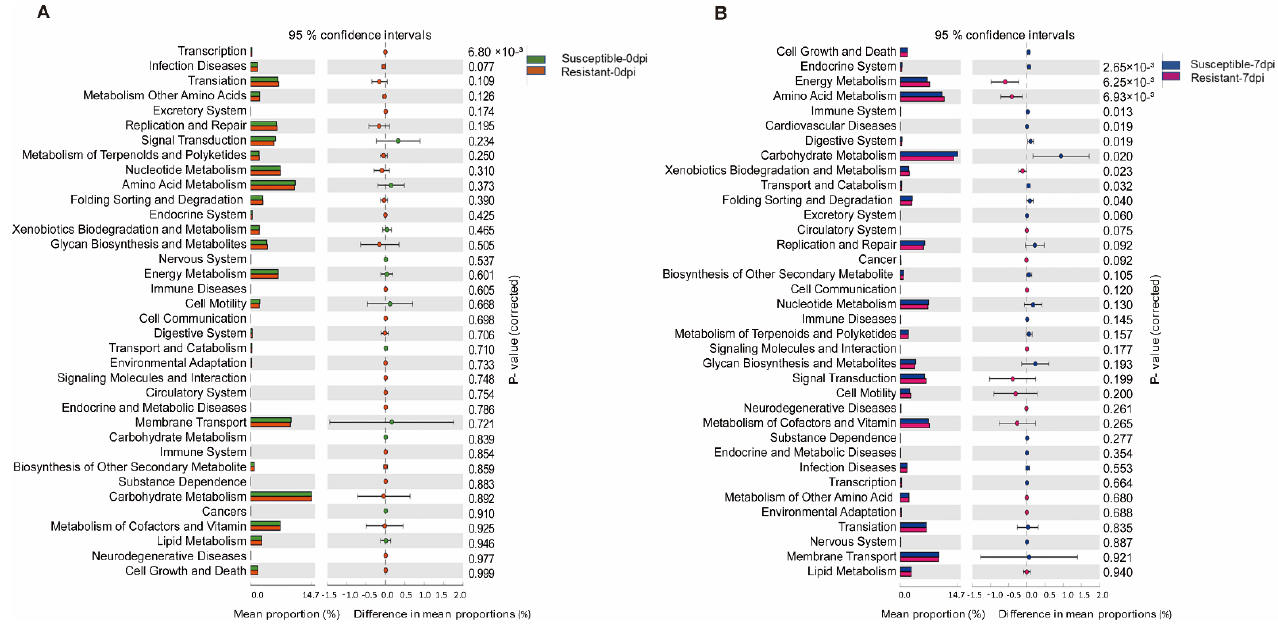
Figure 4. Changes in predicted metagenomic functions of gut bacterial in susceptible and resistant pigs at 0 ( A ) and 7 dpi ( B ), respectively. p ≤ 0.05 represents a significant difference. ( A ) green boxes, susceptible 0 dpi group; orange boxes, resistant 0 dpi group; ( B ) blue boxes, susceptible 0 dpi group; red boxes, resistant 7 dpi group.